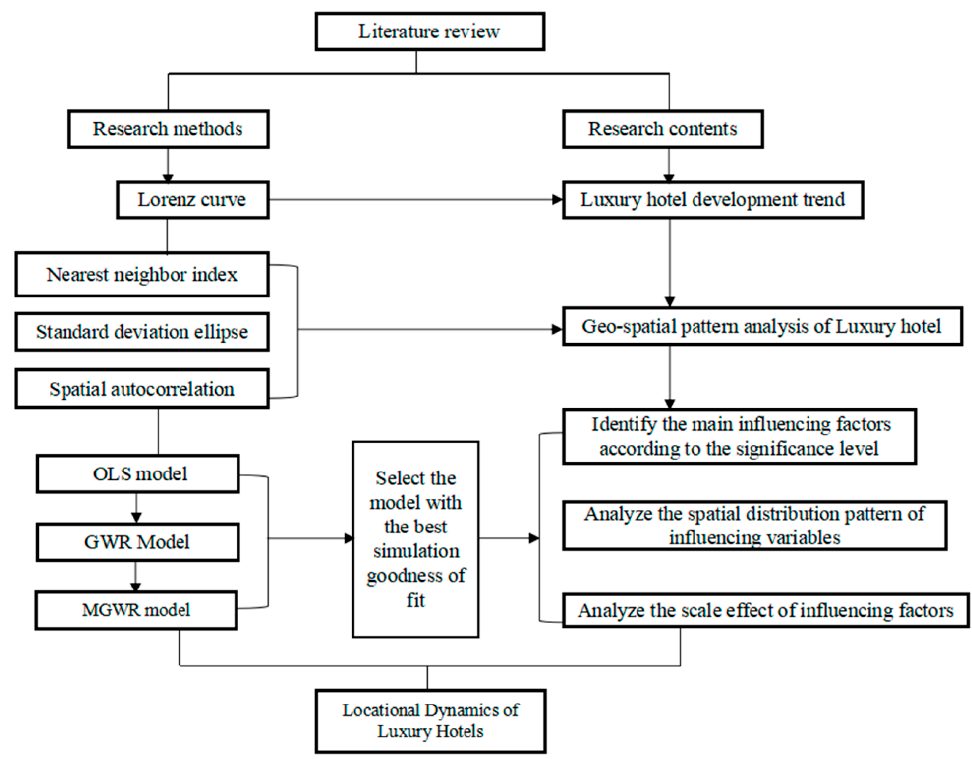
Figure 1. The technical flowchart of this study.